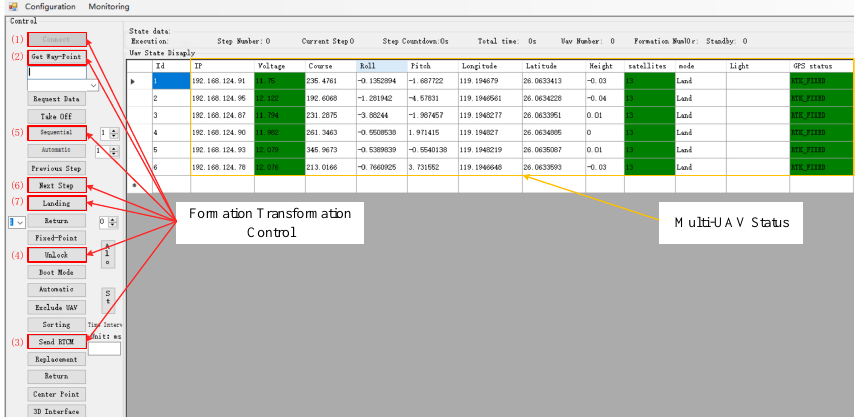
Figure 7. Real-time monitoring and control